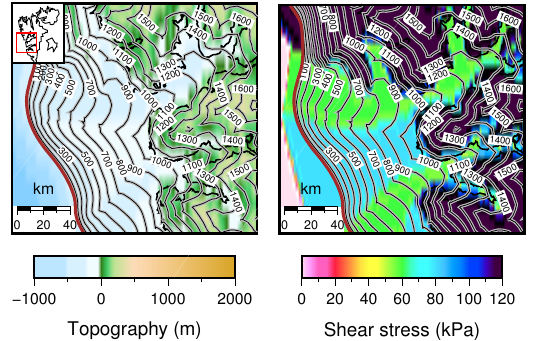
Figure 4. (a) Reference ice sheet reconstruction with a 1km spac- ing and 10m contour interval using the topography and basal shear stress in Fig. 2. (b) The difference between a model calculated with a 20km spacing and 20m contour interval and the reference recon- struction shown in (a) . This demonstrates that the lower resolution tends to overestimate the ice surface elevation in mountainous re- gions.